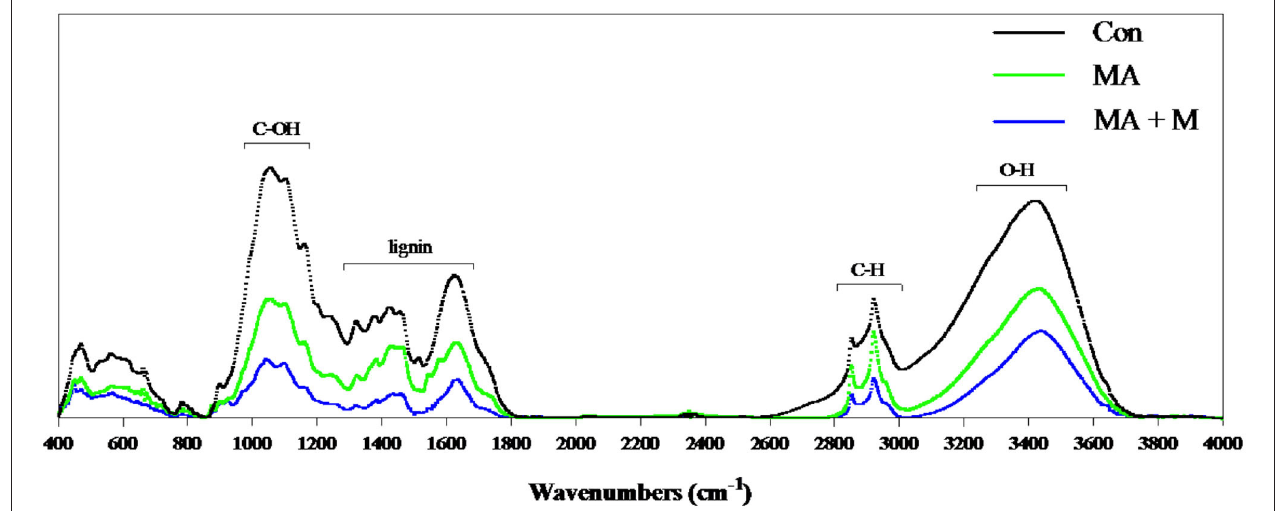
FIGURE 3 | FTIR spectroscopy of rice straw after MA pretreatment. Con, no additive, control; MA, added microecological agents; MA + M, a combination of microecological agents and molasses.